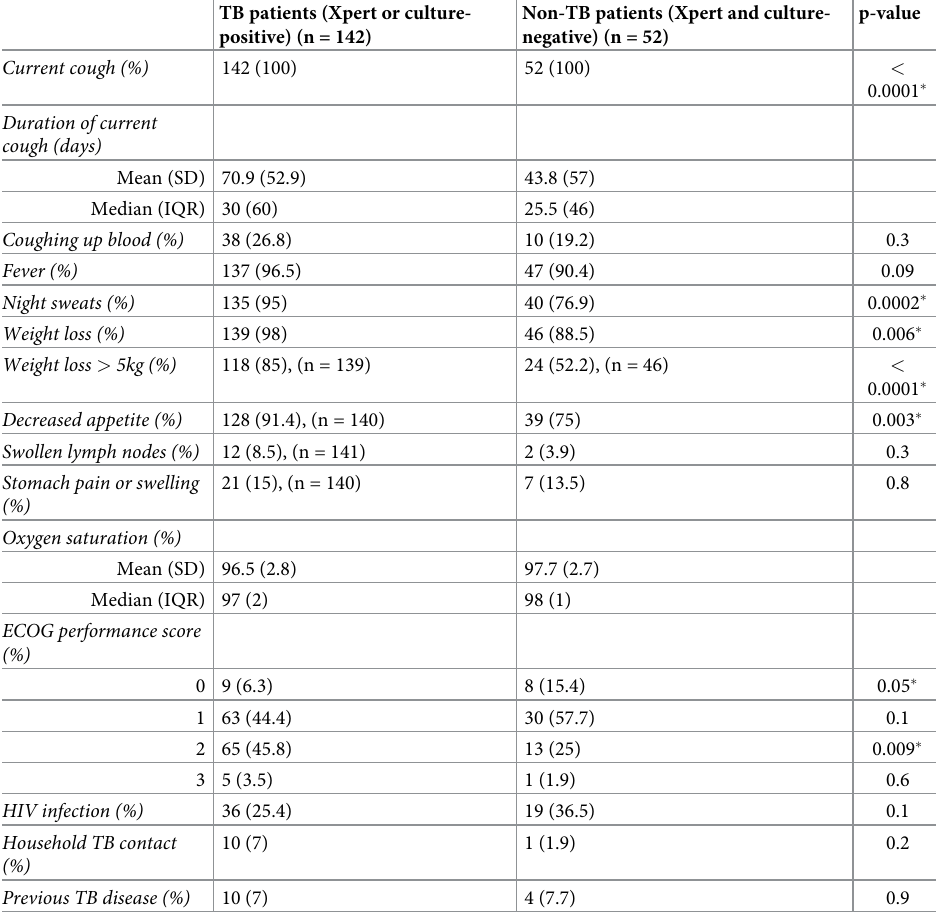
Table 2. Clinical characteristic of